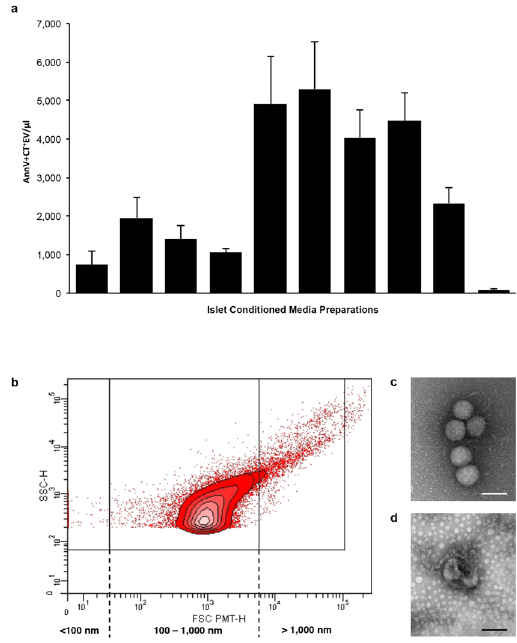
Figure 3. Human islet conditioned media contains a heterogeneous population of AnnV + CellTracker + EV. ( a ) Bar graph showing the mean levels of each ICM (n = 10) detected by flow cytometry varies in their content of AnnV + Cell Tracker + EV after 24 hours in culture. ( b ) Representative contour plot (FSC vs SSC) shows the peak density of AnnV + Cell Tracker + EV is within 100 nm to 1,000 nm size based on the detection of 100, 500 and 1,000 nm silica beads. ( c , d ) Visualization of fractionated ICM by whole mount negative staining TEM confirms the presence of membrane vesicles. Scale bars represent 100 nm. Data are expressed as mean ± SEM of n = 3 independent experiments performed on ICM from ten (n = 10) different donors.